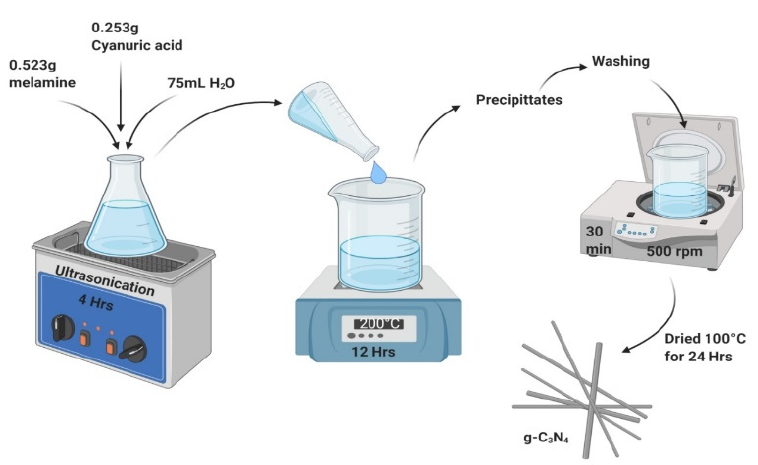
Figure 1. Schematic representation of the formation of graphitic carbon nitride (g-C 3 N 4 ).